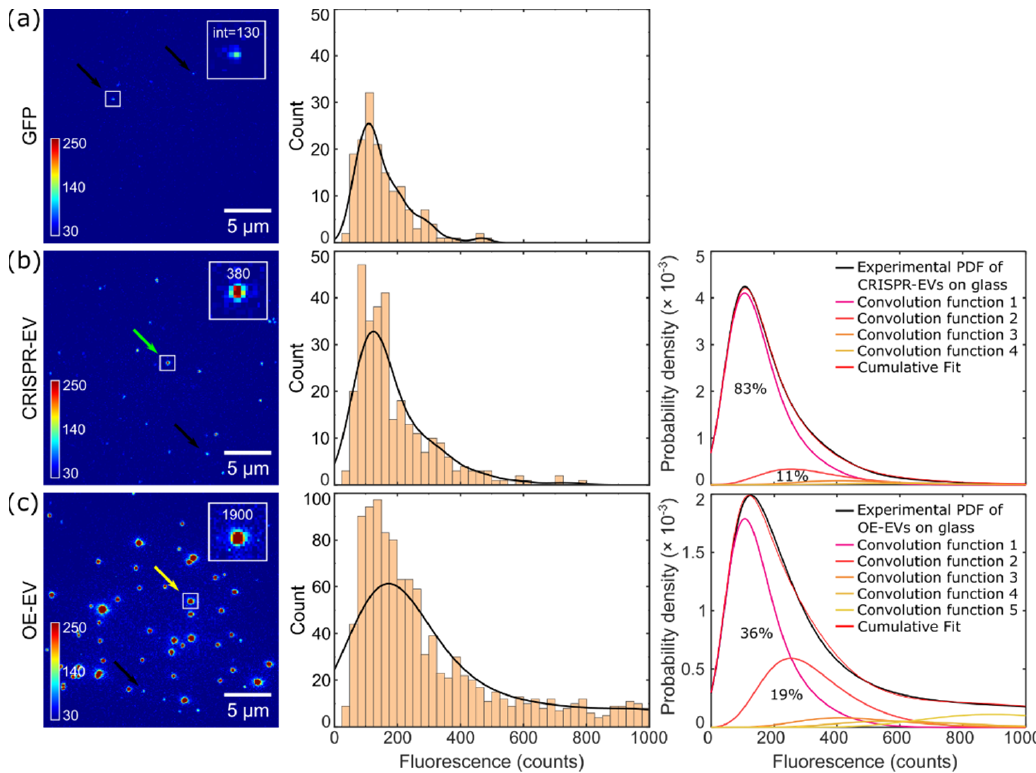
Figure 3. Fluorescence signals of single ( a ) GFPs, ( b ) CRISPR-EVs, and ( c ) OE-EVs that were immo- bilized on Poly-D-Lysine (PDL)-coated glass cover slips. The spots on the fluorescence image (left column) were fitted with a gaussian and then the integrated intensity for each spot were determined. The middle column shows histograms and the probability density function (PDF) as a black solid line for each population, respectively. The probability densities of GFP-labeled CRISPR-EVs and OE-EVs were convoluted with multiple GFP PDFs (right column). The probability density function convolution of GFP intensities with CRISPR-EVs (83%—DOL = 1, 11%—DOL = 2, 4%—DOL = 3, 2%—DOL ≥ 4) and OE-EVs (36%—DOL = 1, 19%—DOL = 2, 3%—DOL = 3, 42%—DOL ≥ 4), respec- tively, show that over-expression introduces a higher number of CD63-GFP constructs into the EV membrane. (DOL = degree of labeling). Black arrows indicate typical signals for a single GFP, the green arrow indicates an EV assigned with two GFP labels and the yellow arrow indicates an EV with multiple GFP